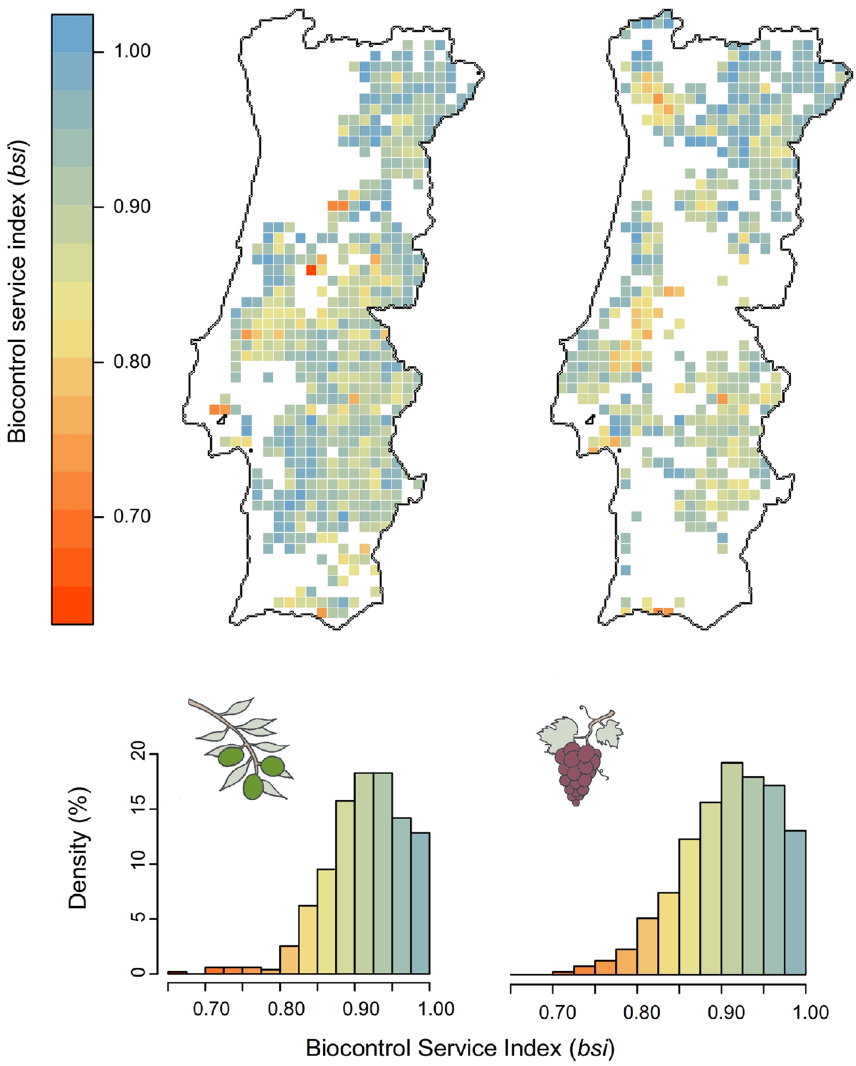
Figure 3. Biocontrol service indices ( bsi ) in olive groves (left panels) and vineyards (right panels) throughout Portugal. Upper panels show the spatial distribution patterns of estimated bsi values for each crop, while lower panels depict the frequency distribution histograms (%) using the 10 × 10 km grid cells as unit. Maps were generated using the free and open source Geographic Information System QGIS v2.8 (https:// qgis. org/ en/